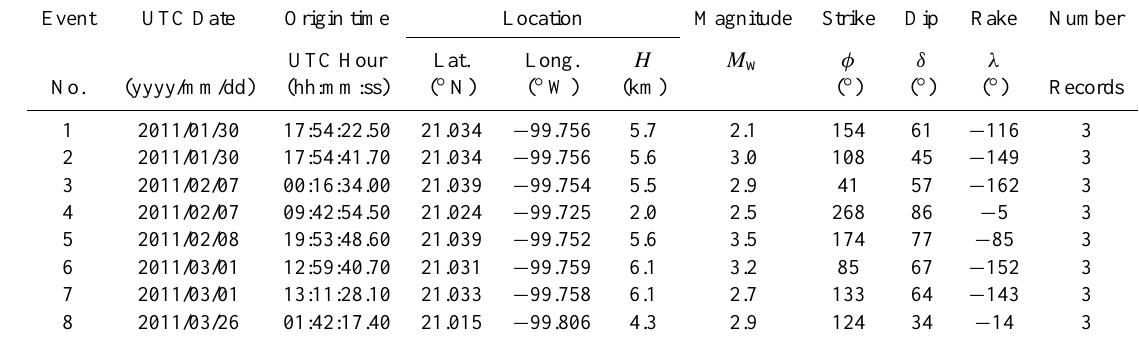
Table 4. Earthquake source parameters of best fit solutions from the Peñamiller sequence. Event